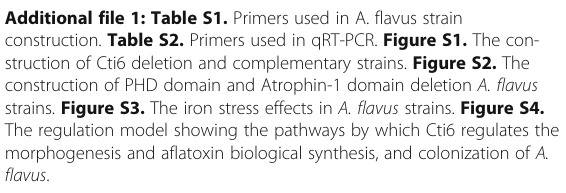
strains. Figure S3. The iron stress effects in A. flavus strains. Figure S4. The regulation model showing the pathways by which Cti6 regulates the morphogenesis and aflatoxin biological synthesis, and colonization of A. flavus